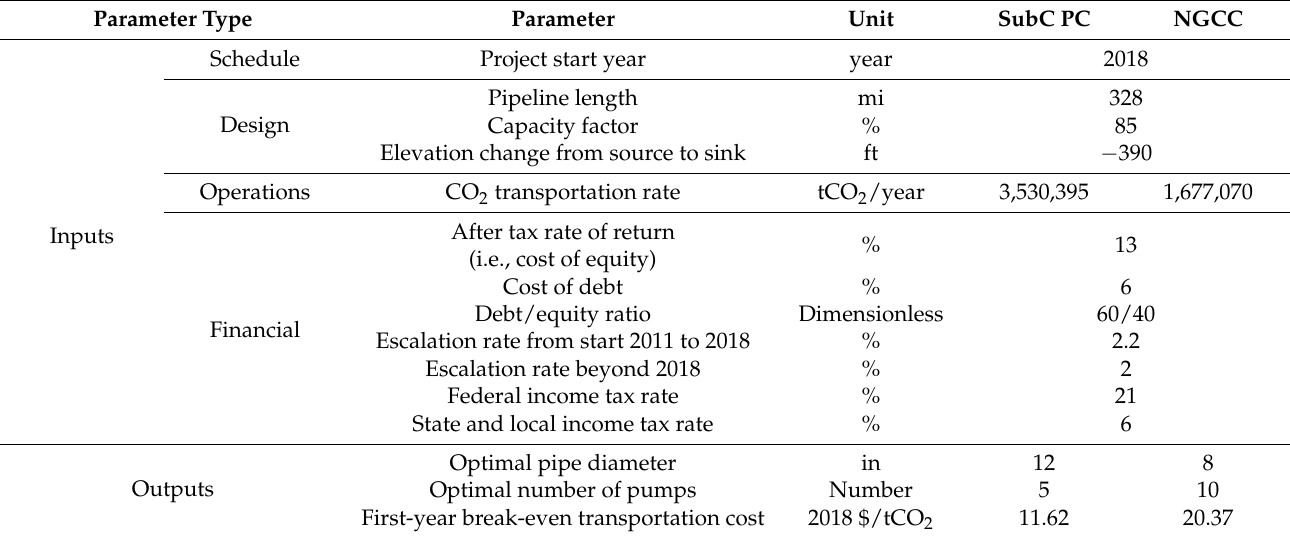
Table A2. Critical parameters and key outputs for CO 2 _T_COM runs in the study. Parameter Type Parameter